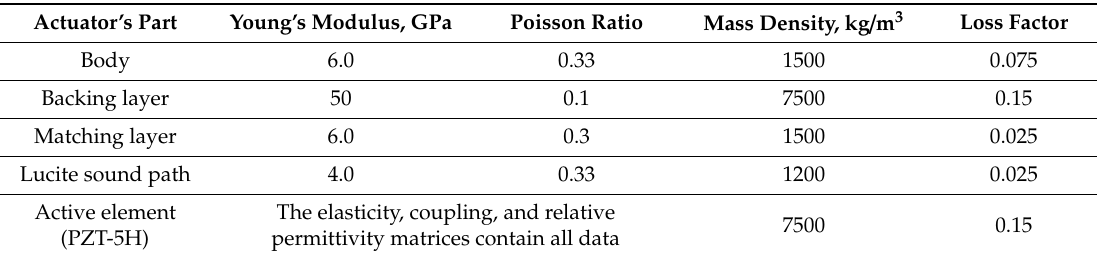
Table 2. Mechanical properties of the actuator parts’